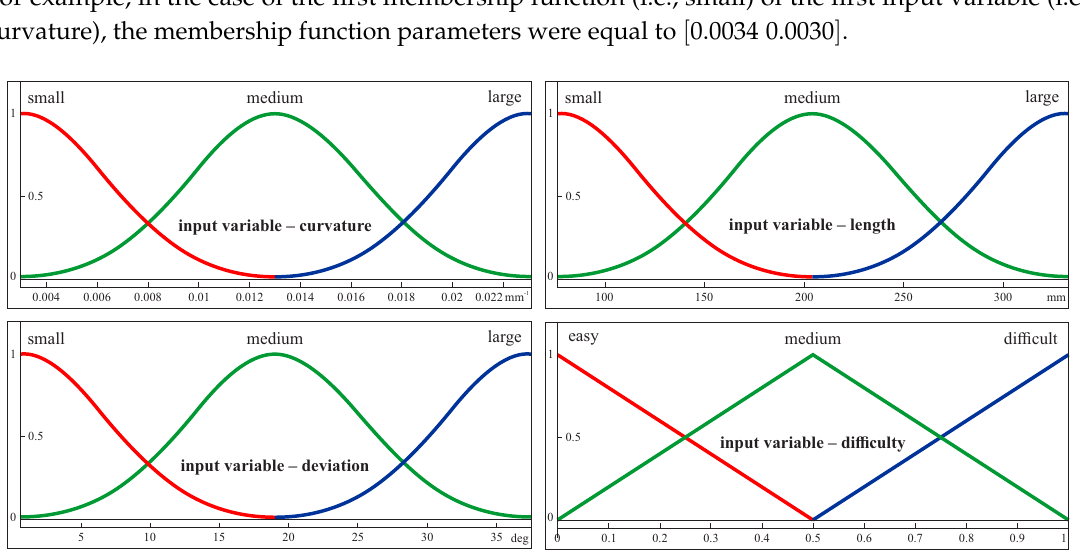
Figure 6. The membership functions for the input parameters in the case of the first free-form